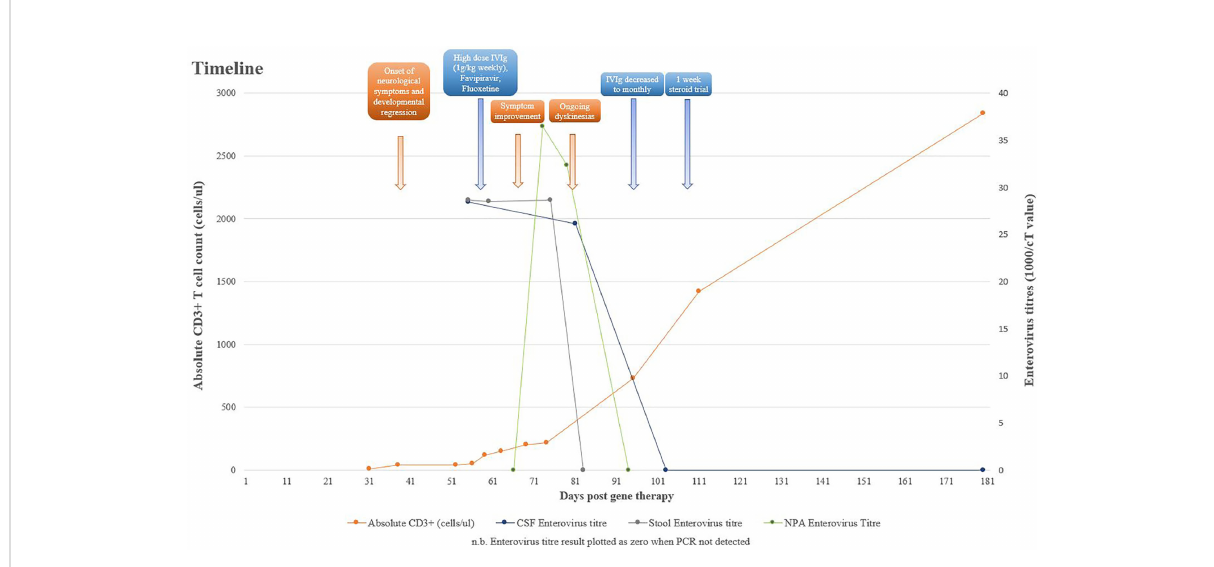
FIGURE 1 Timeline of clinical symptoms with relevant laboratory parameters and treatments.